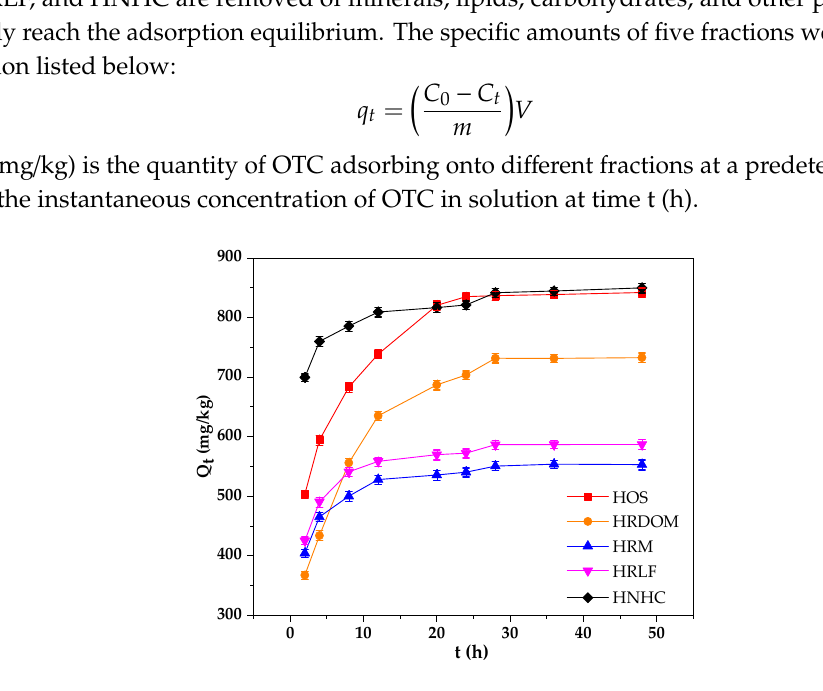
Figure 2. Adsorption characteristics of OTC by different fractions.